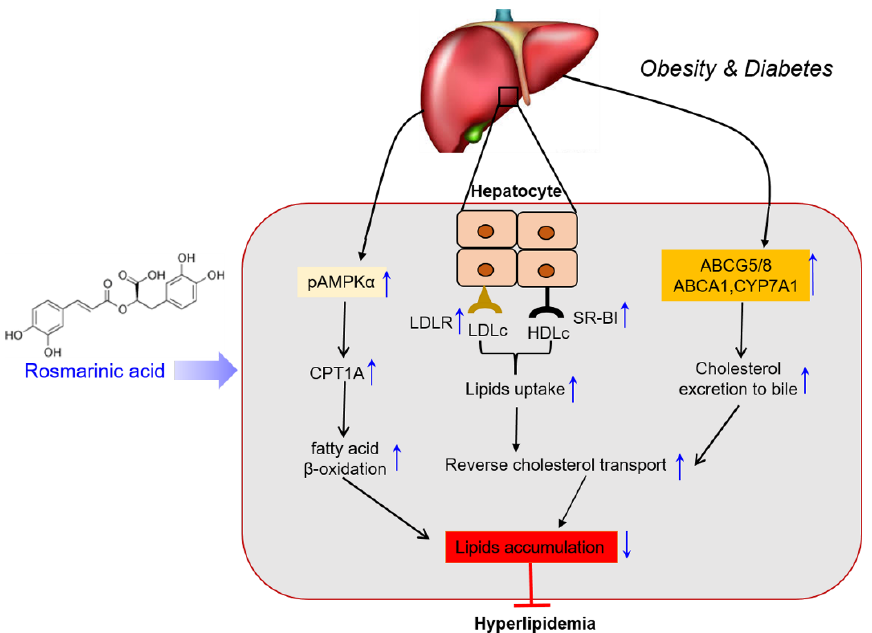
Figure 6. Schematic presentation by which RA induces cholesterol excretion and protects the liver in HFD-fed mice. A schematic diagram illustrating the protective mechanisms of rosmarinic acid against hyperlipidemia. Rosmarinic acid enhances reverse cholesterol transport (RCT) and lipid me- tabolism. Rosmarinic acid mediates RCT through increased plasma cholesterol uptake and subse- quent hepatobiliary excretion and induces lipid metabolism by increasing fatty acid β -oxidation in AMPK-dependent activation of CPT1A, thus modulating lipid accumulation and attenuating hy- perlipidemia in HFD-fed